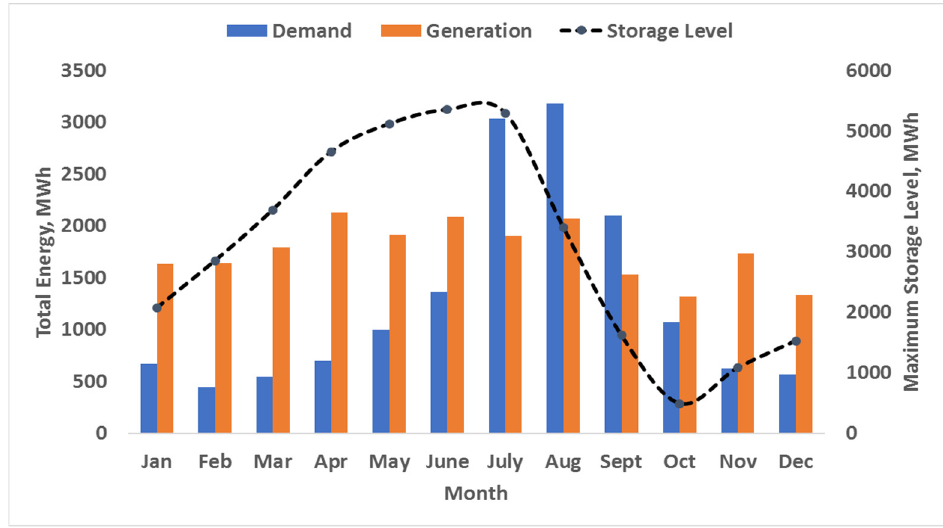
Figure 3. Total monthly energy production, consumption, and maximum storage level during each month of the year.